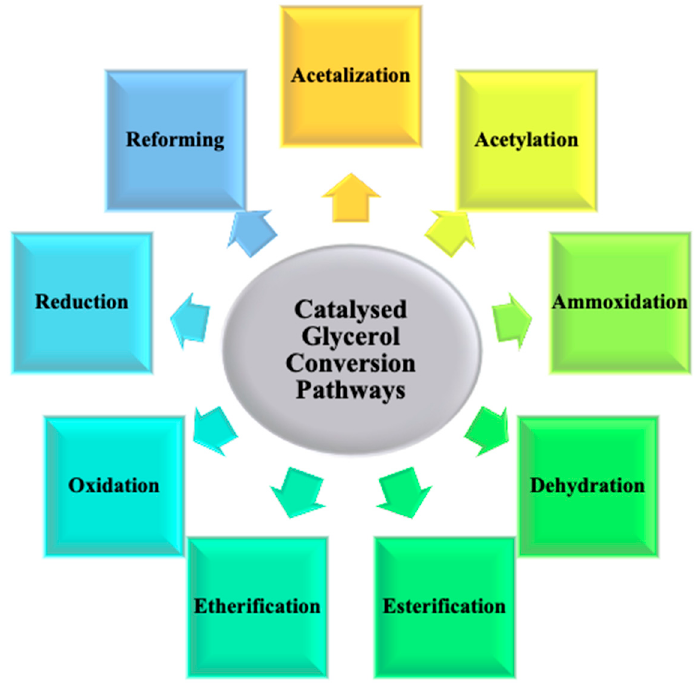
Figure 3. Various glycerol catalytic conversion pathways [37].